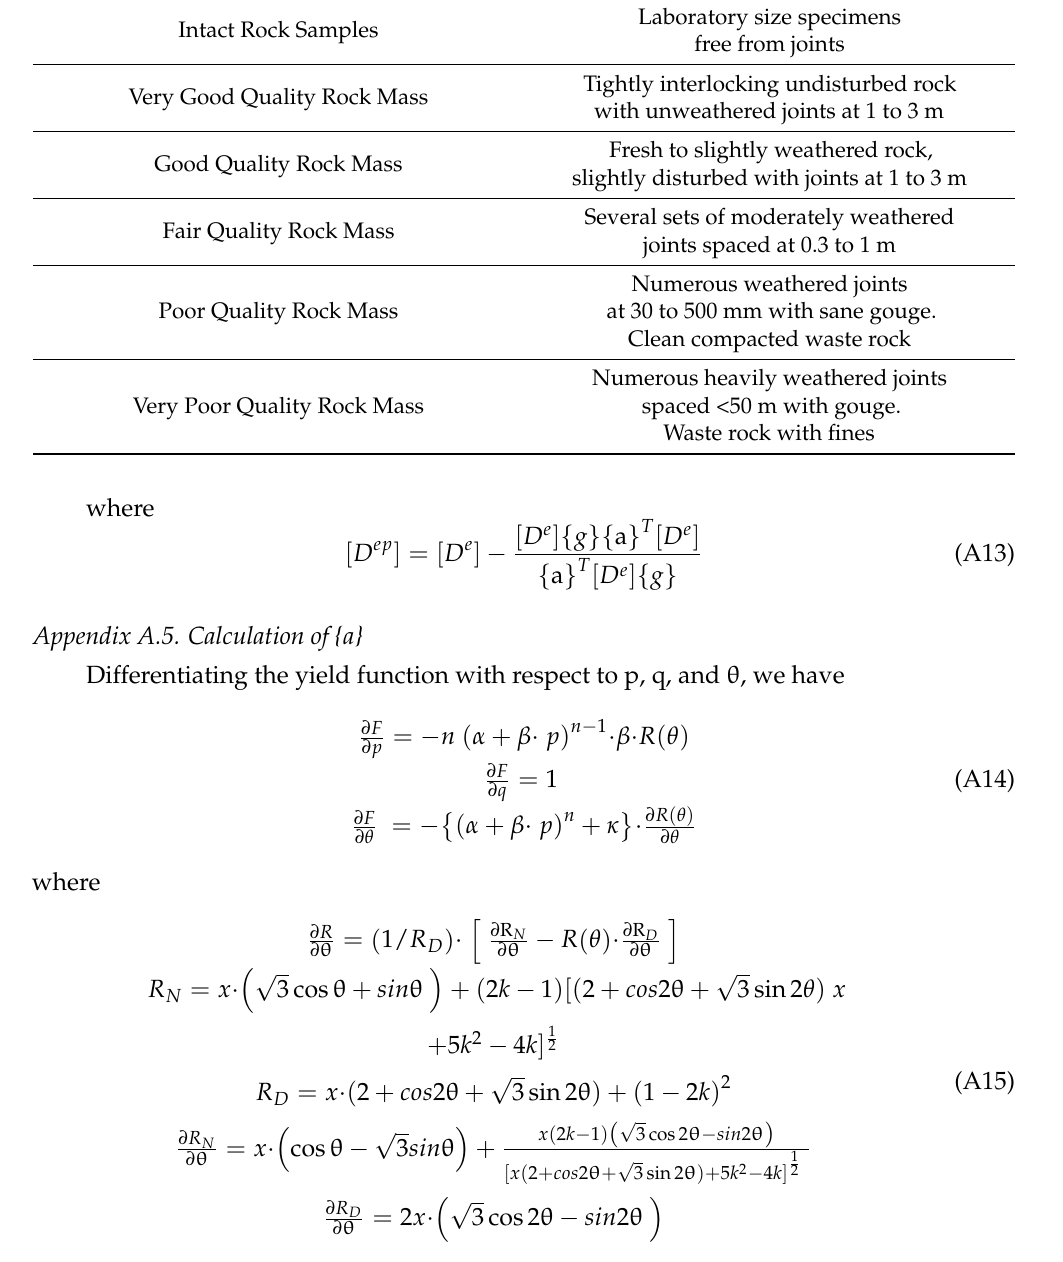
Table A2. Description of Rock Quality in Table